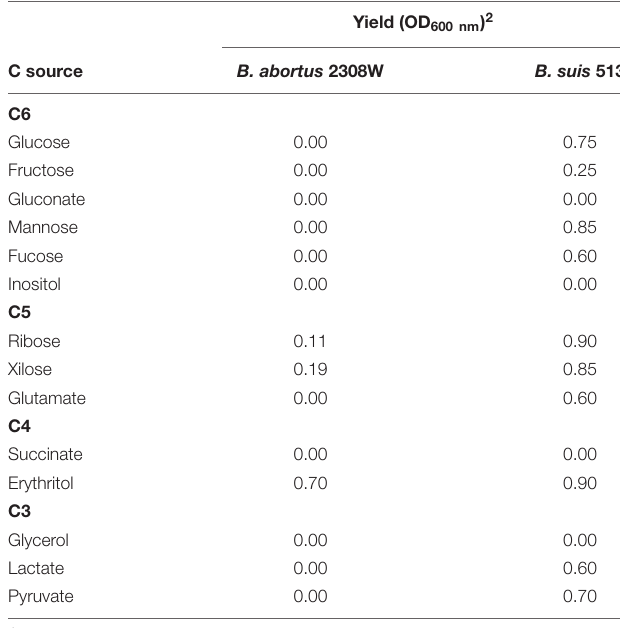
TABLE 1 | Growth of B. abortus 2308W and B. suis 513 on single C6, C4, and C3 compounds as the only C source 1 .